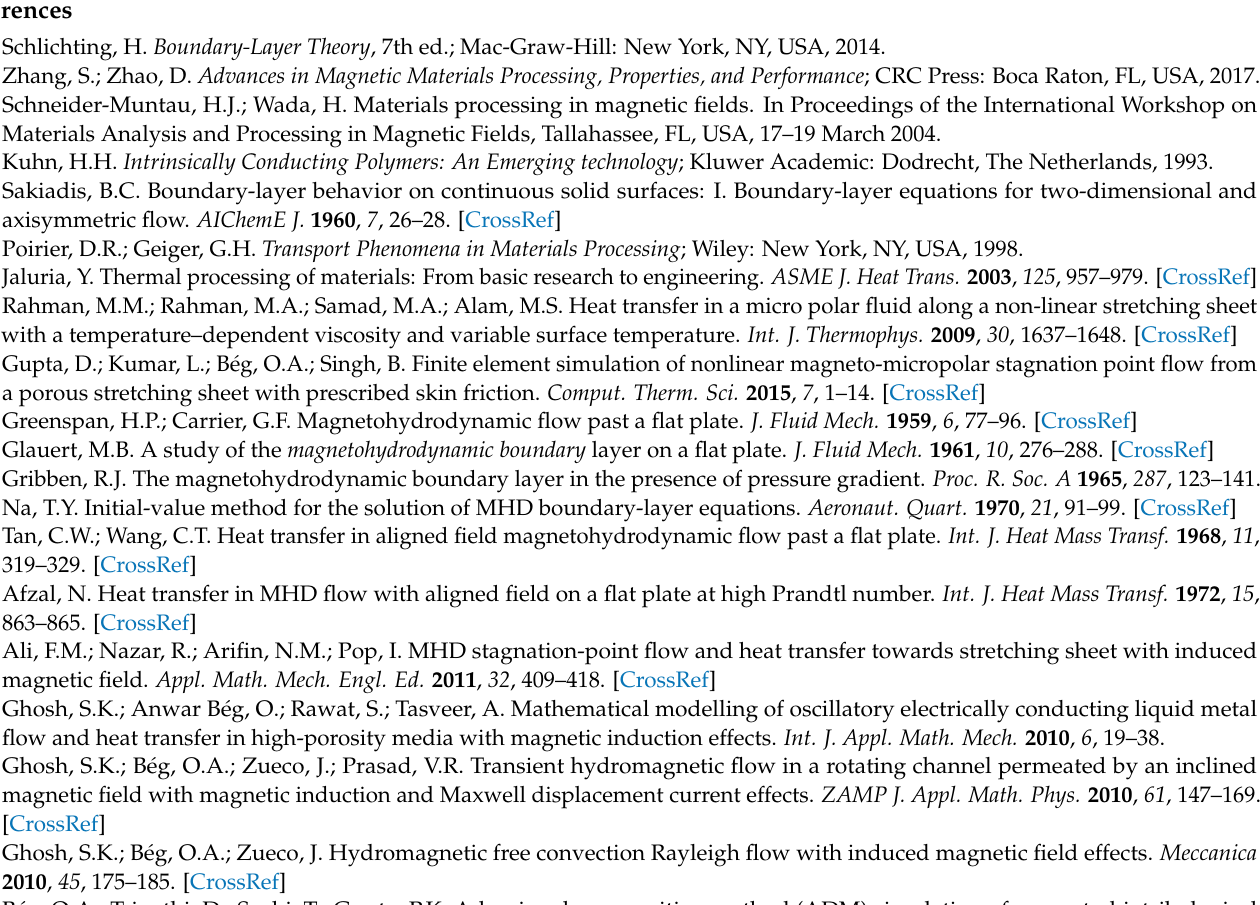
ξ Figure 17. Effect of the magnetic field and buoyancy force parameter on the Nusselt number. 0 β=1 β=2 β=3 Figure 18. Effect of the magnetic field and buoyancy force parameter on the skin friction. 6. Conclusions The processing of magnetic polymer materials at high temperatures, under the influ- ence of an aligned magnetic field and heat radiation, has been modeled using an extensive mathematical model for steady two-dimensional boundary layer heat transmission in